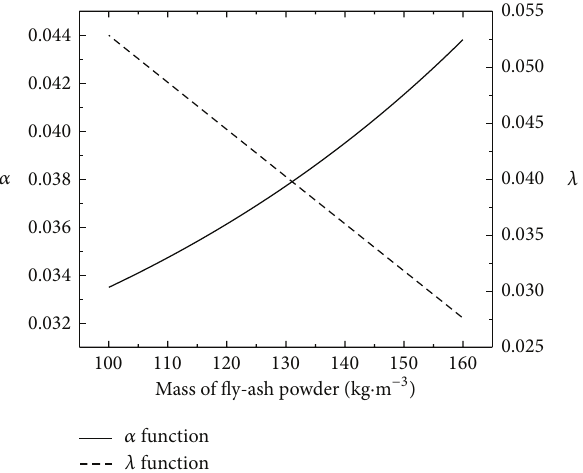
Figure 15: 𝛼 and 𝜆 functions on fly-ash powder addition